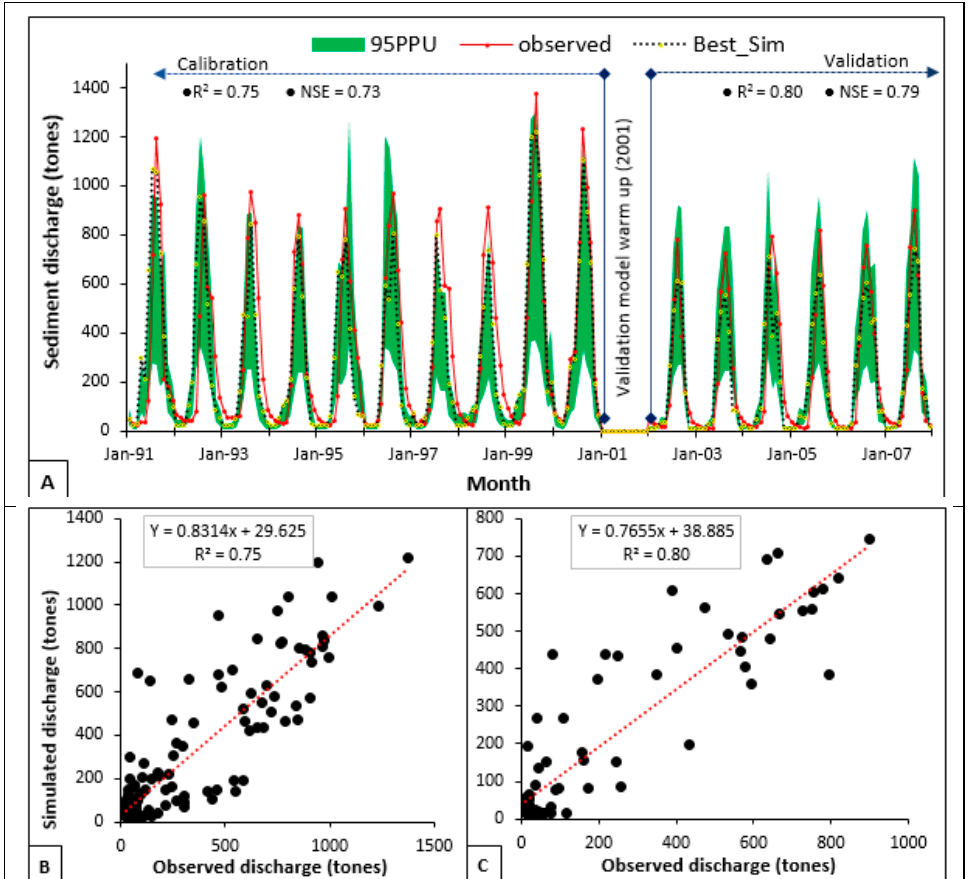
Figure 9. Monthly catchment sediment yield for calibration (1991–2000) and validation (2002–2007) ( A ); scatter plot of observed and simulated monthly sediment discharge (Q s ) for calibration (1991–2000) ( B ); and validation (2002–2007) ( C ).